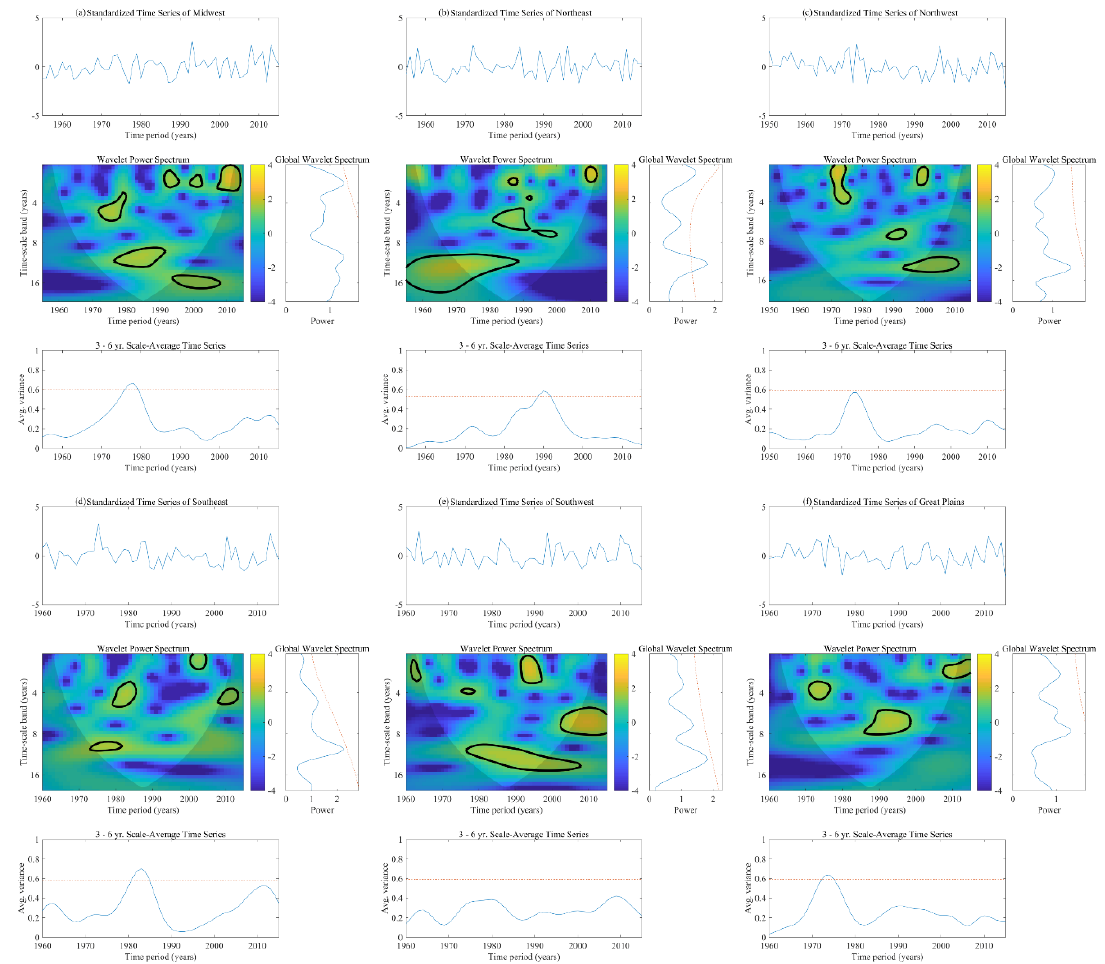
Figure 9. Continuous wavelet transforms (CWT) along with the global wavelet spectrum and the 3- to 6-year scale average time series of ( a ) Midwest, ( b ) Northeast, ( c ) Northwest, ( d ) Southeast, ( e ) Southwest, and ( f ) Great Plains streamflow. Warmer (yellow) color represents higher variance in data. Zones with significant variance against 5% red noise are delineated by black contour lines.